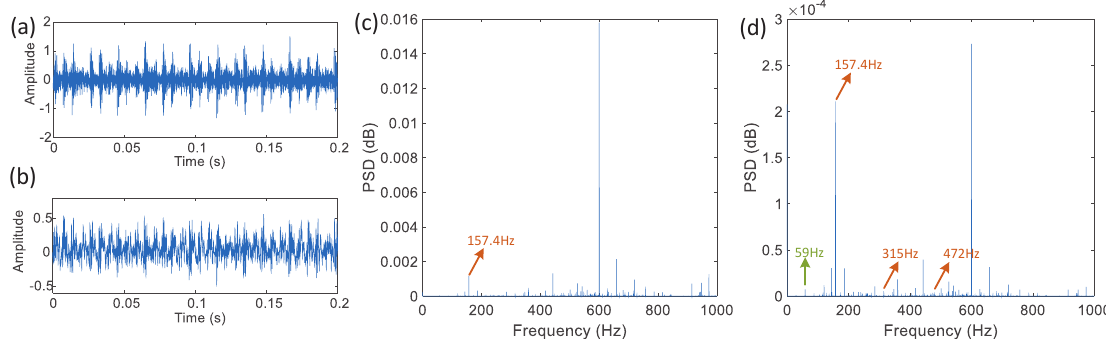
Figure 8. The vibration signal ( a ), the synchronous error ( b ), the power spectral density of inner ring damage using the vibration signal ( c ) and the synchronization error ( d ).